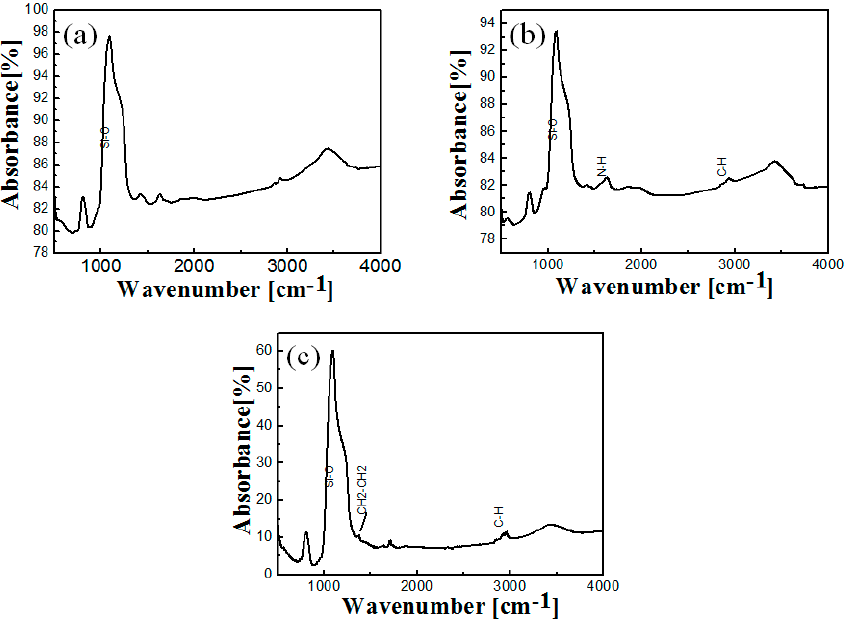
Figure 3. FT-IR spectra of ( a ) non-functionalized; ( b ) amino-functionalized and ( c ) ethane-functionalized hollow core-mesoporous shell silica nanospheres.